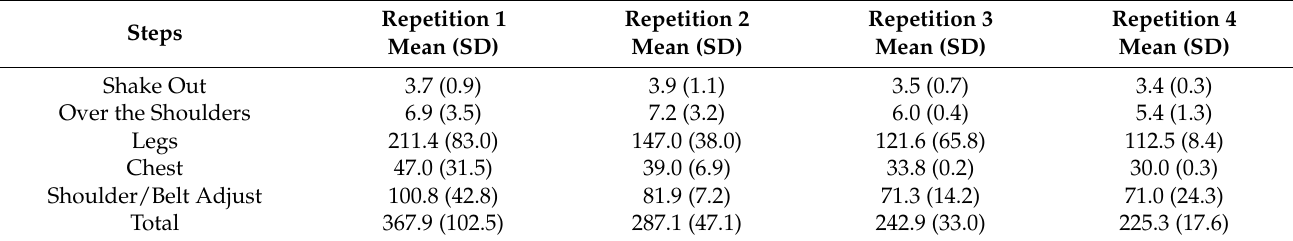
Table 4. Mean harness donning times and standard deviations for 22 participants in